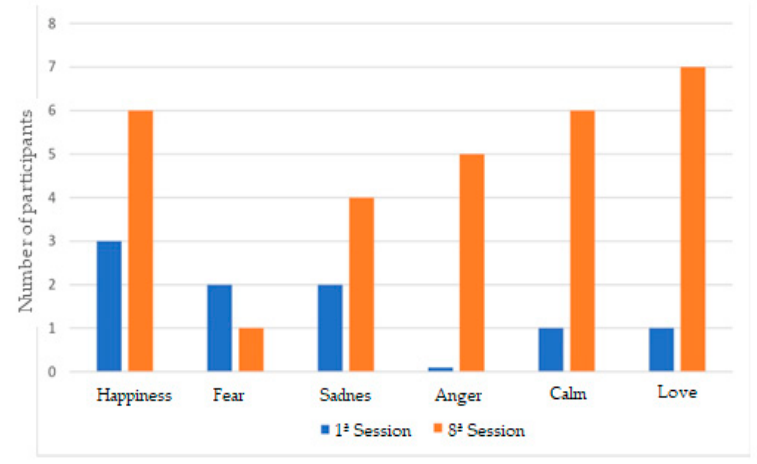
Figure 1. 1st Category; Image recognition .